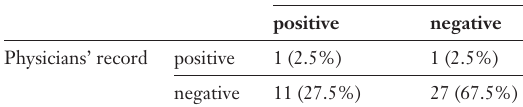
Clinical value of vaccination history: anamnesis versus titre (n = 39).